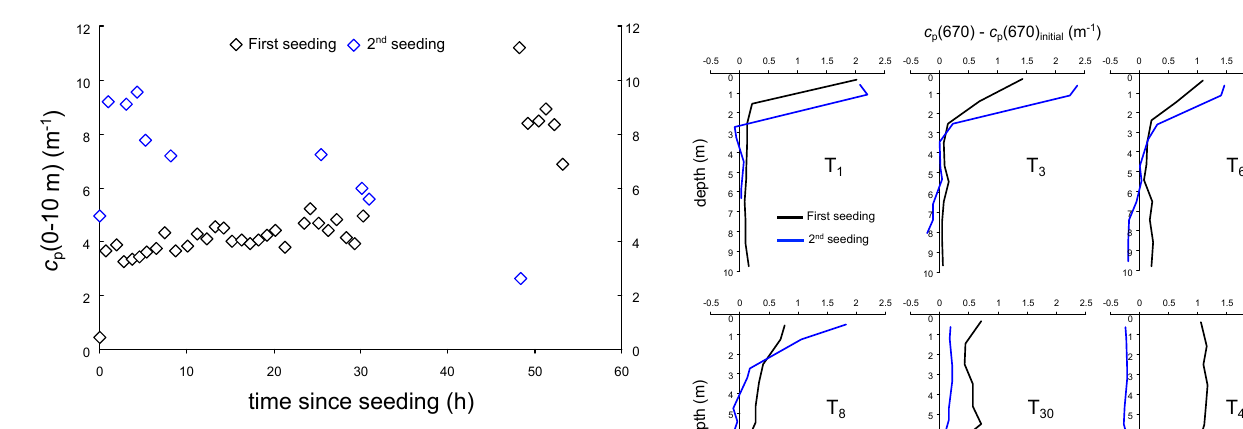
Fig. 2. Temporal evolution of the vertically integrated (0–10m) par- ticle attenuation coefficient ( c p (0–10m)) during both seeding ex- periments.